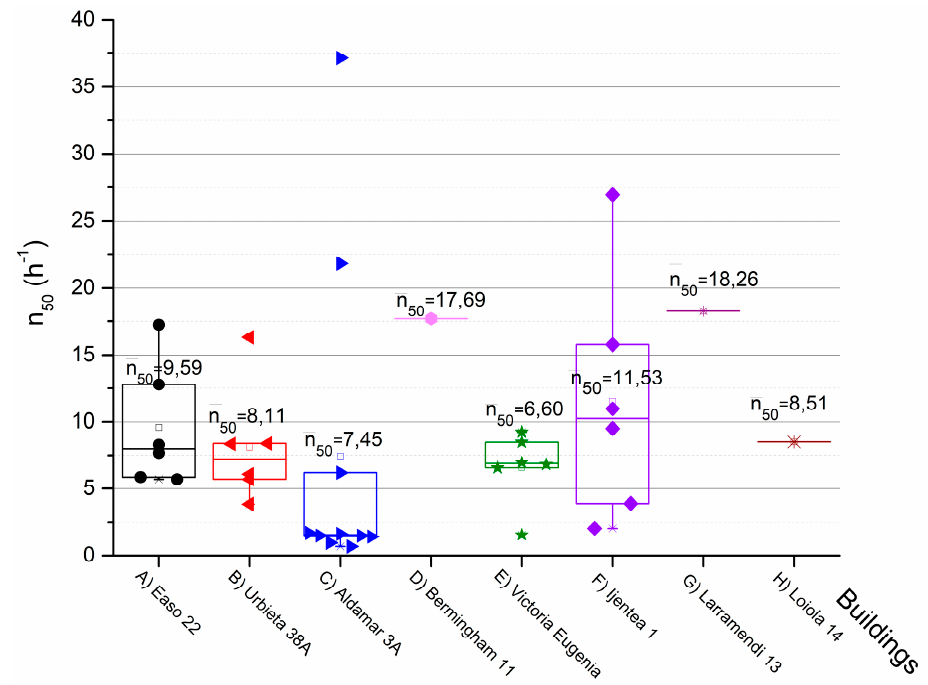
Figure 7. Box-plot of the air tightness of analyzed enclosures, classified by building.